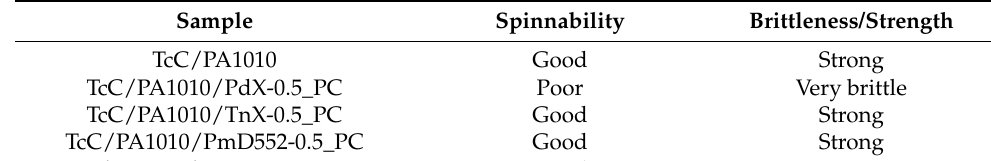
Table 2. Summary of the ease of TcC/PA1010_50:50 filament extrusion and resulting filament char- acter using the pellet-coating method.